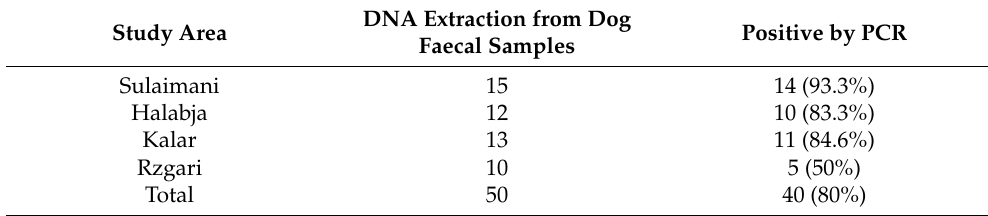
Figure 3. Gel electrophoresis of PCR product of E. granulosus . M = DNA Ladder, N = negative control, P = positive control, S = Sample. Table 2. The molecular identification of Echinococcus granulosus egg among stray dogs in Sulaimani